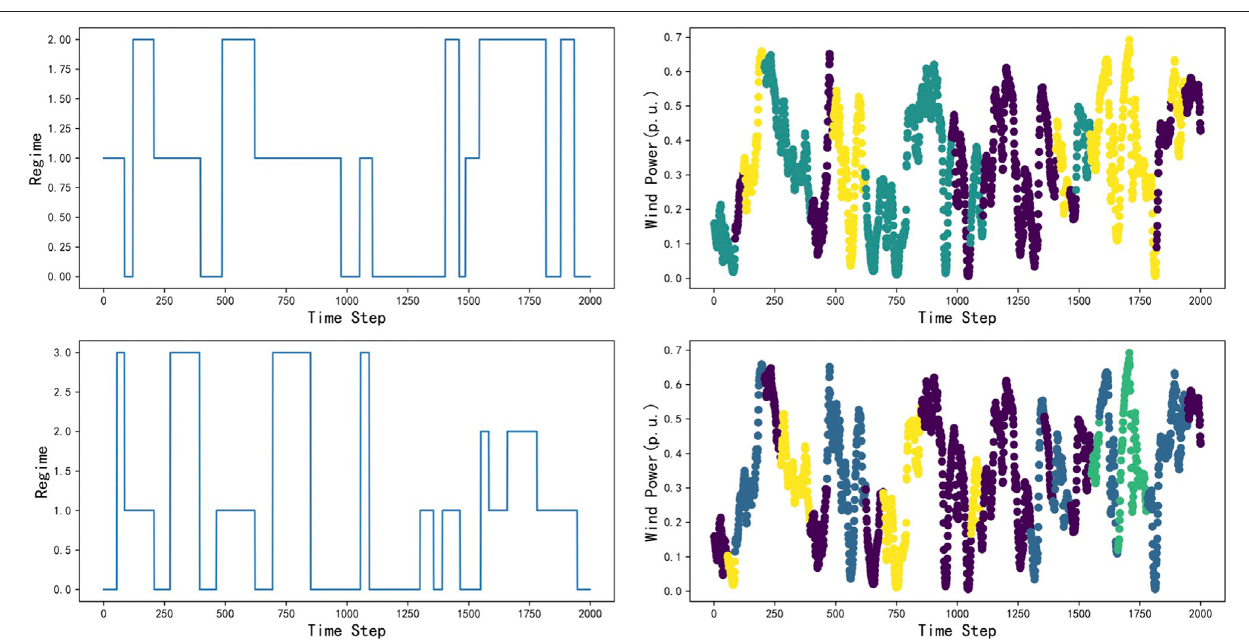
FIGURE 7 | The wind power time series regime division.